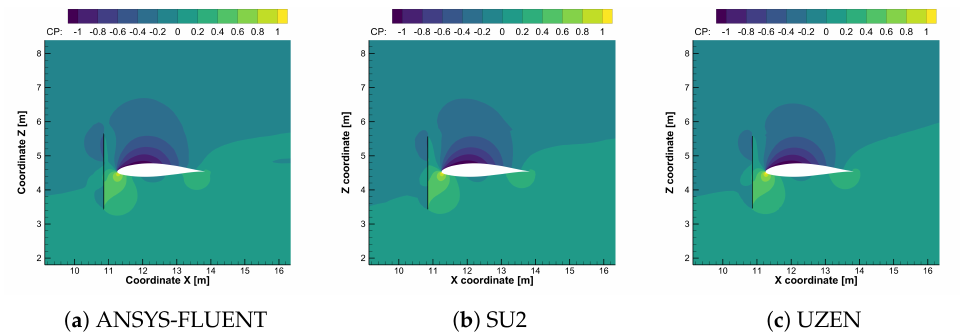
Figure 22. Pressure coefficient contour for power-on condition at α = 4 ◦ .